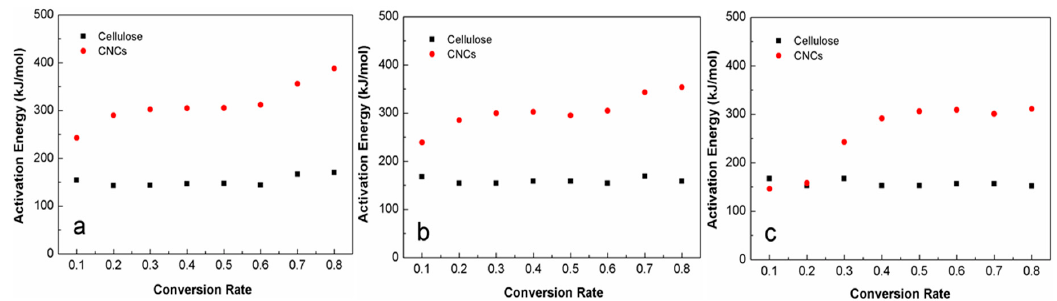
Figure 7. A comparison of apparent activation energy as a function of decomposition conversion rate for the cellulose and the CNCs, calculated by ( a ) Friedman; ( b ) F-W-O; and ( c ) Coats-Redfern methods. Table 2. Activation energy of the cellulose, calculated by the three methods in the range of a = 0.1–0.8. Conversion